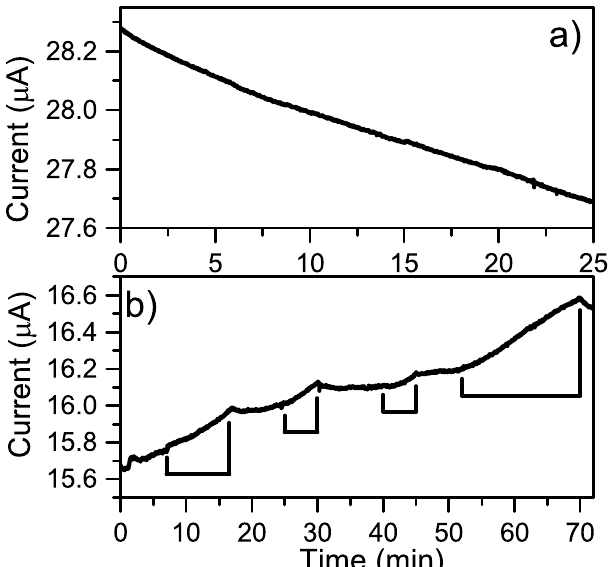
Figure 10. Electrical measurements with cocaine diluted in PBS as the pumping solution with and without the presence of pyrene-N-hydroxysuccinimide ester (NHS)-linked antibodies ( a ) without pyrene-NHS-linked antibodies; ( b ) with pyrene-NHS-linked antibodies, where the indicators show when cocaine in PBS is used as the pumping